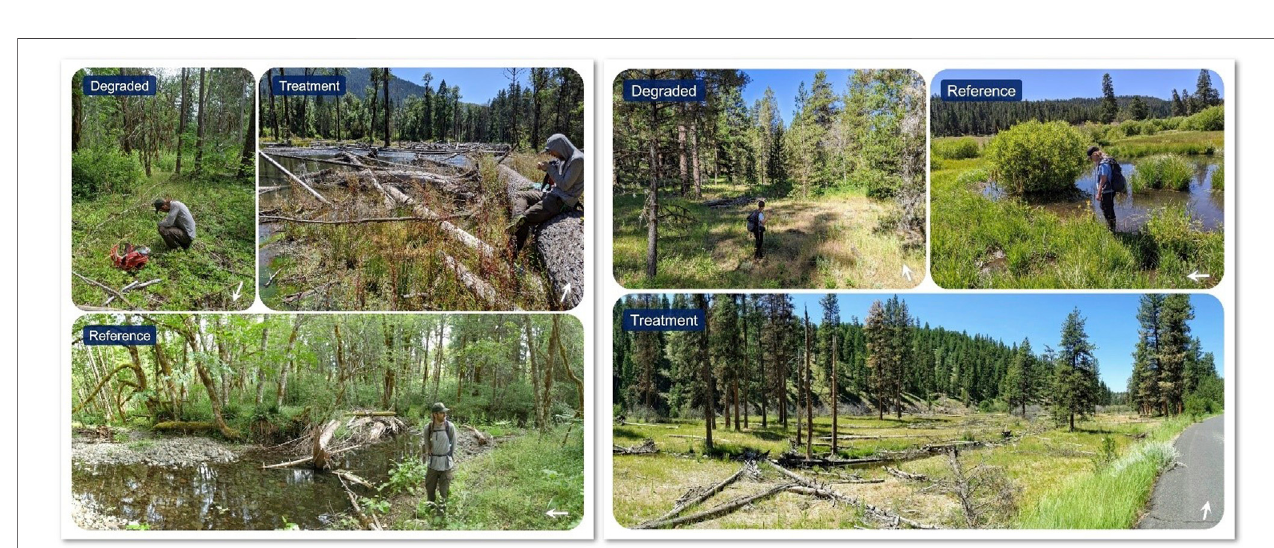
FIGURE5| FieldphotosoftheSouthForkMcKenzieRiverinWillametteNationalForest(leftpanel)andDeepCreekinOchocoNationalForest(rightpanel),Oregon, United States. Each photo is labeled with its assigned class as degraded, treatment, and design reference ( “ Reference ” ), and arrows in the bottom right of each photo indicate fl ow direction. The person in the left panel is 1.86 m tall and the person in the right panel is 1.58 m tall.